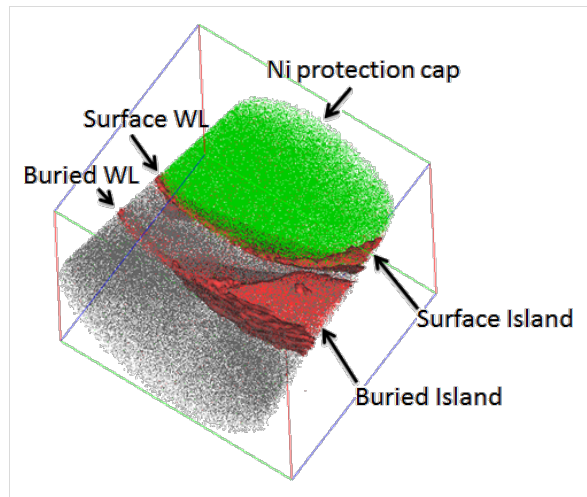
Figure 3: APT volume (100 × 100 × 90 nm 3 ) obtained from the sample. Green, gray, red and blue dots correspond to Ni, Si, Ge and O atoms, respectively. 2 atom % Ge isoconcentration surfaces are also shown (dark red surfaces).